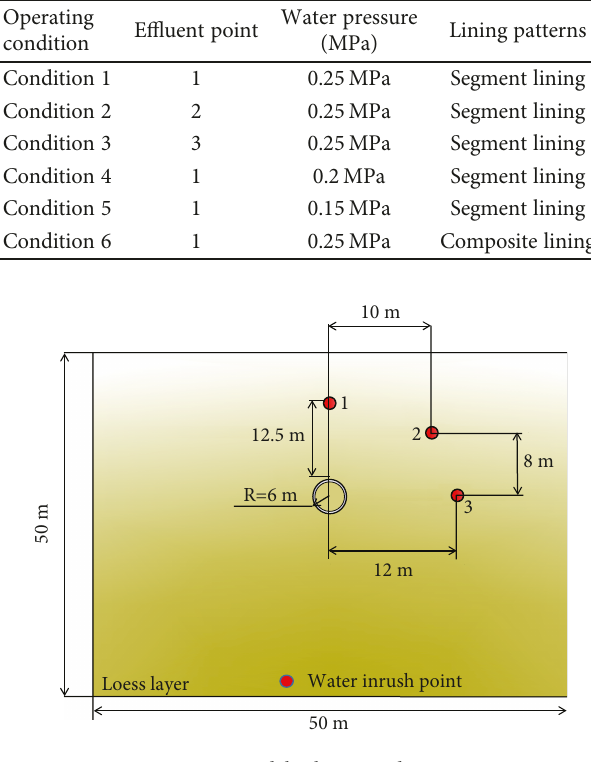
Figure 17: Model schematic diagram.